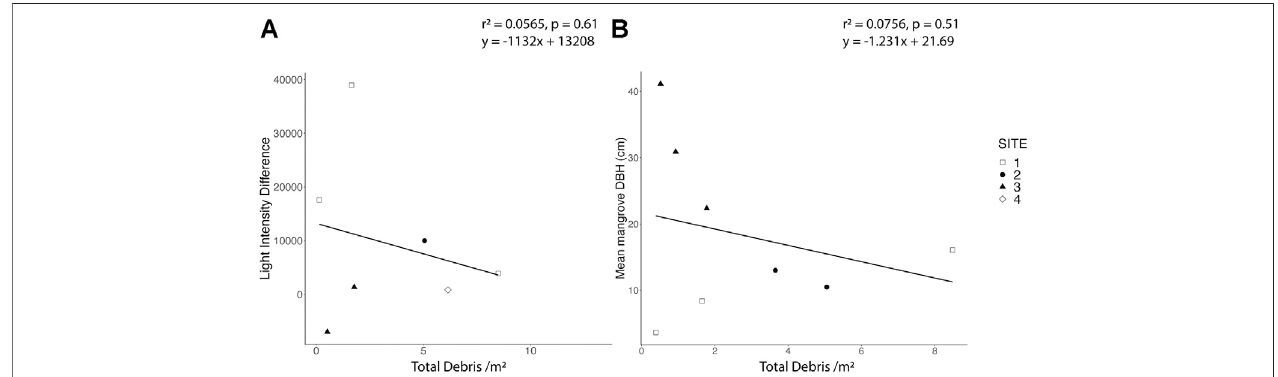
FIGURE5| Scatterplotswiththetotalnumber ofdebrisitemsper m 2 plottedonthe x -axisandmangrove healthindex(DBH,lightintensity)plottedonthe y -axis.A trendlineforalinearregressionisshownwiththeequation, r 2 value,and p valuedenotingsigni fi canceforeachgraph. (A) Averagelightintensitydifferencevs.totaldebris. Light intensity differenceis a proxy for canopy cover. Smaller differences in light intensity infers lower density of leaves, and poorer canopy cover. (B) Average mangrove diameter at breast height (cm) vs. total debris.